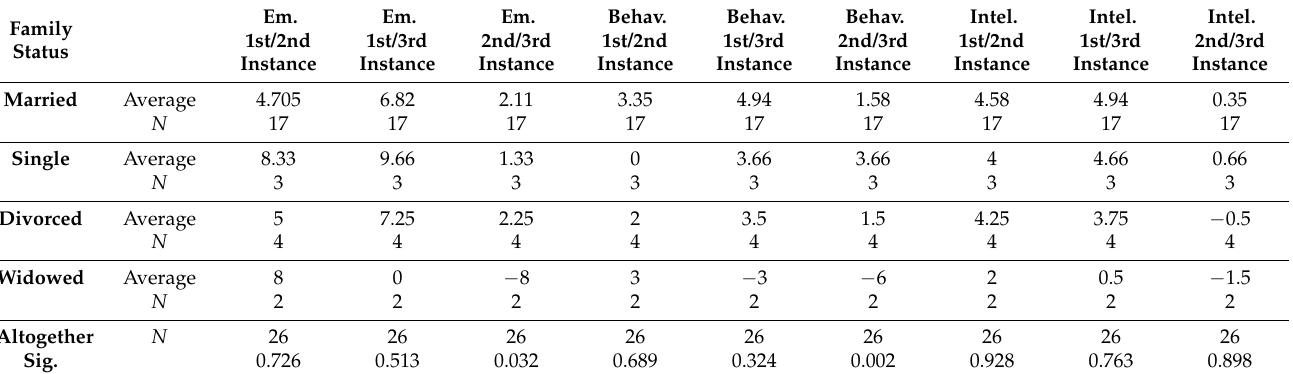
Table 4. Attitudinal change considering family status.